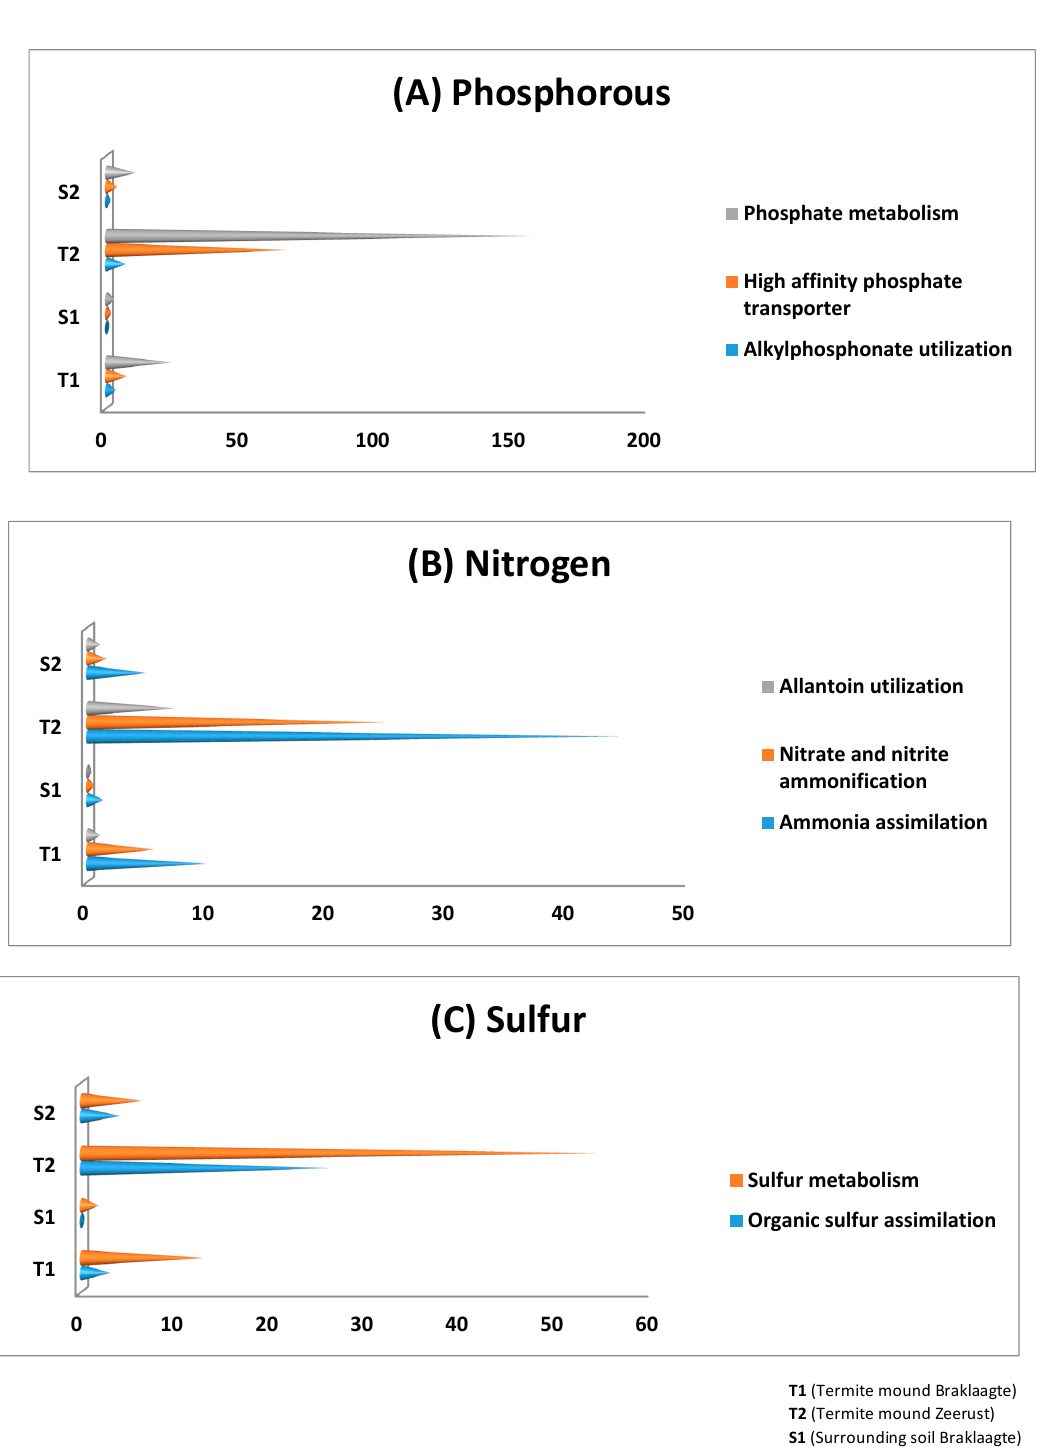
Figure 3. The relative abundance of the ( A ) phosphorus, ( B ) nitrogen, and ( C ) sulfur pathways obtained from termite mound soils and their surrounding soil samples.